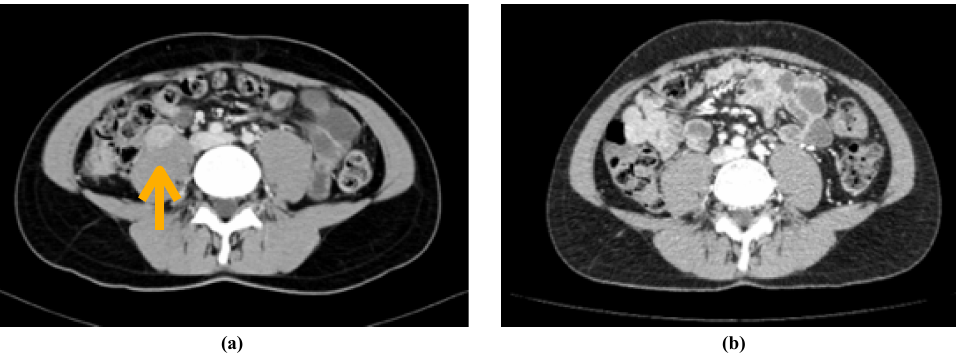
Figure 4. CT scans showing the evolution of the oncological disease. ( a ): CT confirming second progression. Increase of retroperitoneal node and a new node anterior to the right psoas. ( b ): CT with major partial response. Shows stable retroperitoneal node and resolution of the rest of metastatic disease.